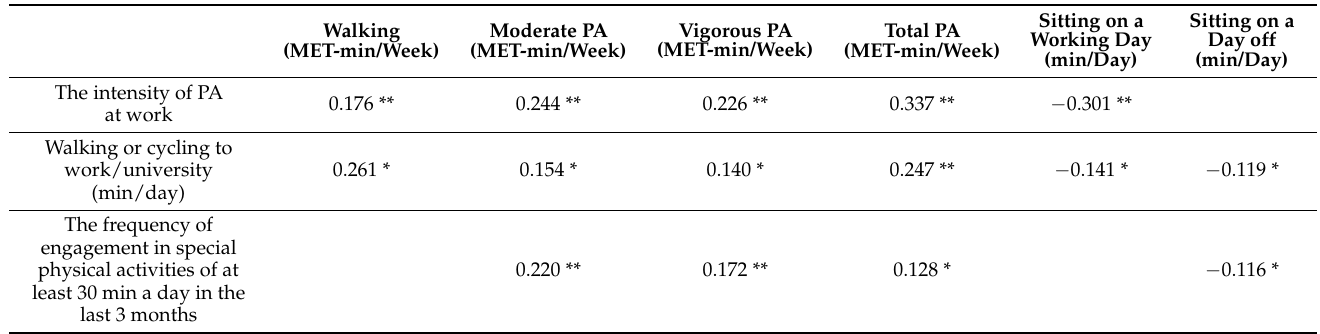
Table 3. Correlation coefficients between IPAQ domains and self-evaluation of PA